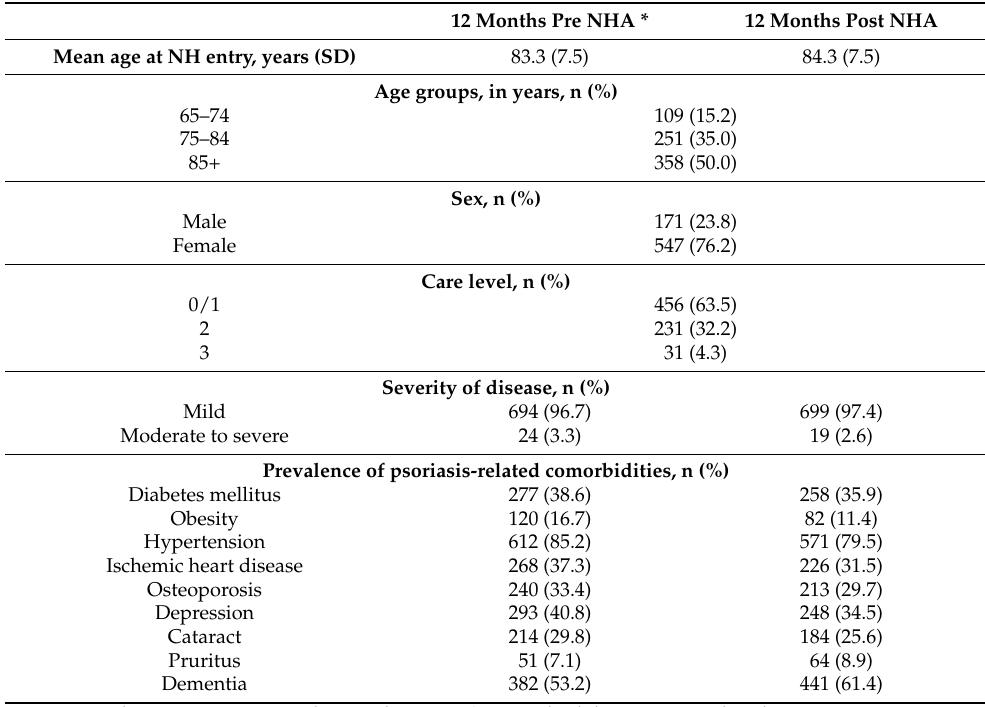
Table 5. Baseline characteristics of patients with psoriasis in the year before and after entering a nursing home (N = 718)